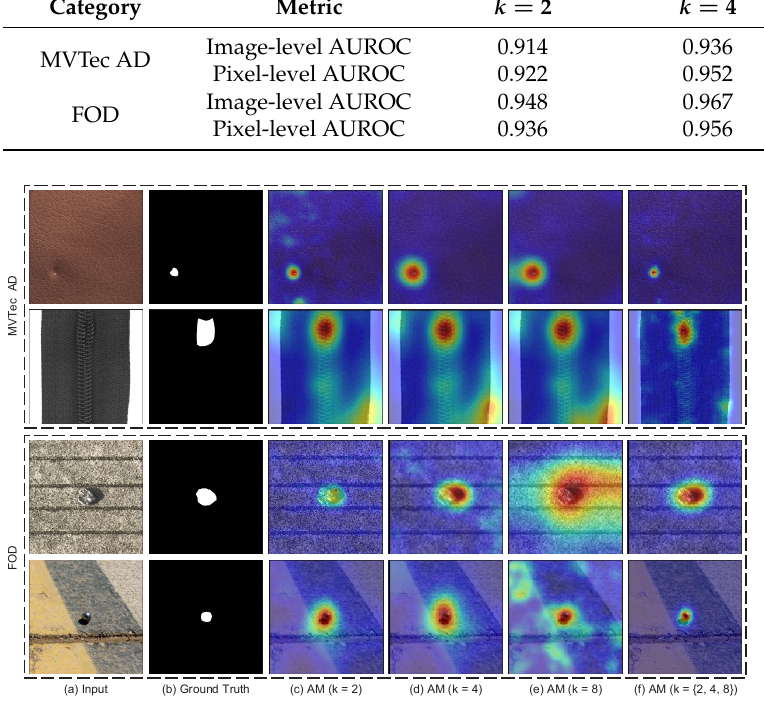
Figure 8. Qualitative results of MSFI trained and evaluated on a single gird size on the MVTec AD and FOD datasets. AM ( k = 2), AM ( k = 4) and AM ( k = 8) respectively represent the anomaly map of MSFI trained with a single grid sizes of 2, 4 and 8. AM ( K = { 2,4,8 } ) represents the anomaly map of MSFI trained and evaluated on the set K = { 2,4,8 }